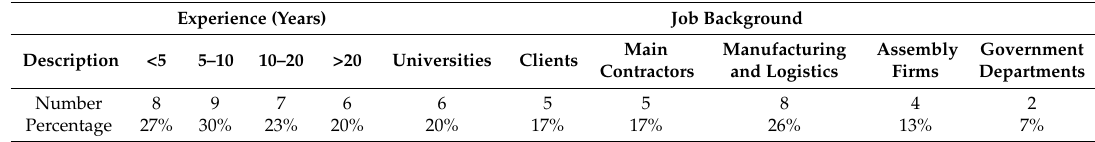
Table 3. Demographic information of the participants.